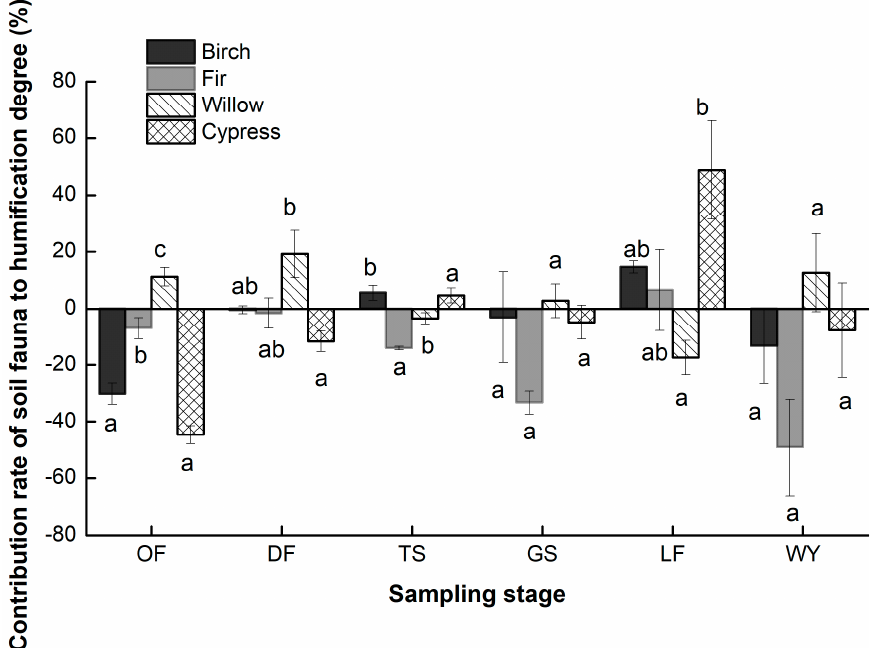
Figure 7. The contribution rate of soil fauna to four litter humification degree in different stages (mean ± standard error, n = 3). OF: onset of freezing stage, DF: deep freezing stage, TS: thawing stage, GS: growing season, LF: leave falling stage. OF: onset of freezing stage, DF: deep freezing stage, TS: thawing stage, GS: growing season, LF: leaf falling stage, WY: whole year. The letters a–c mean in the sampling stage with different letters differ significantly, P < 0.05.